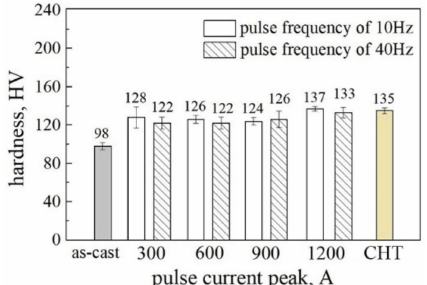
Figure 9. The hardness of the Al-7Si-0.55Mg alloy after aging treatment at di ff erent